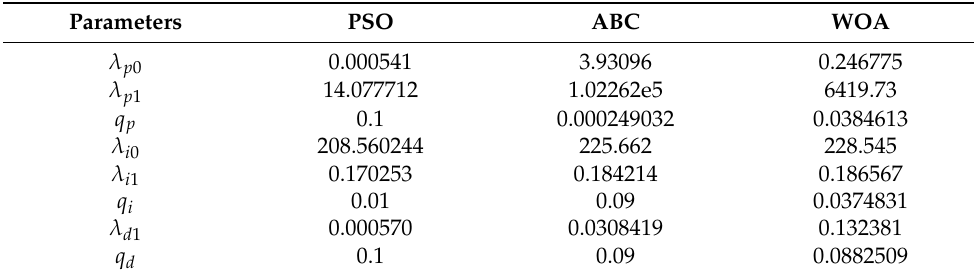
Table 2. The best GAPID control parameters for each